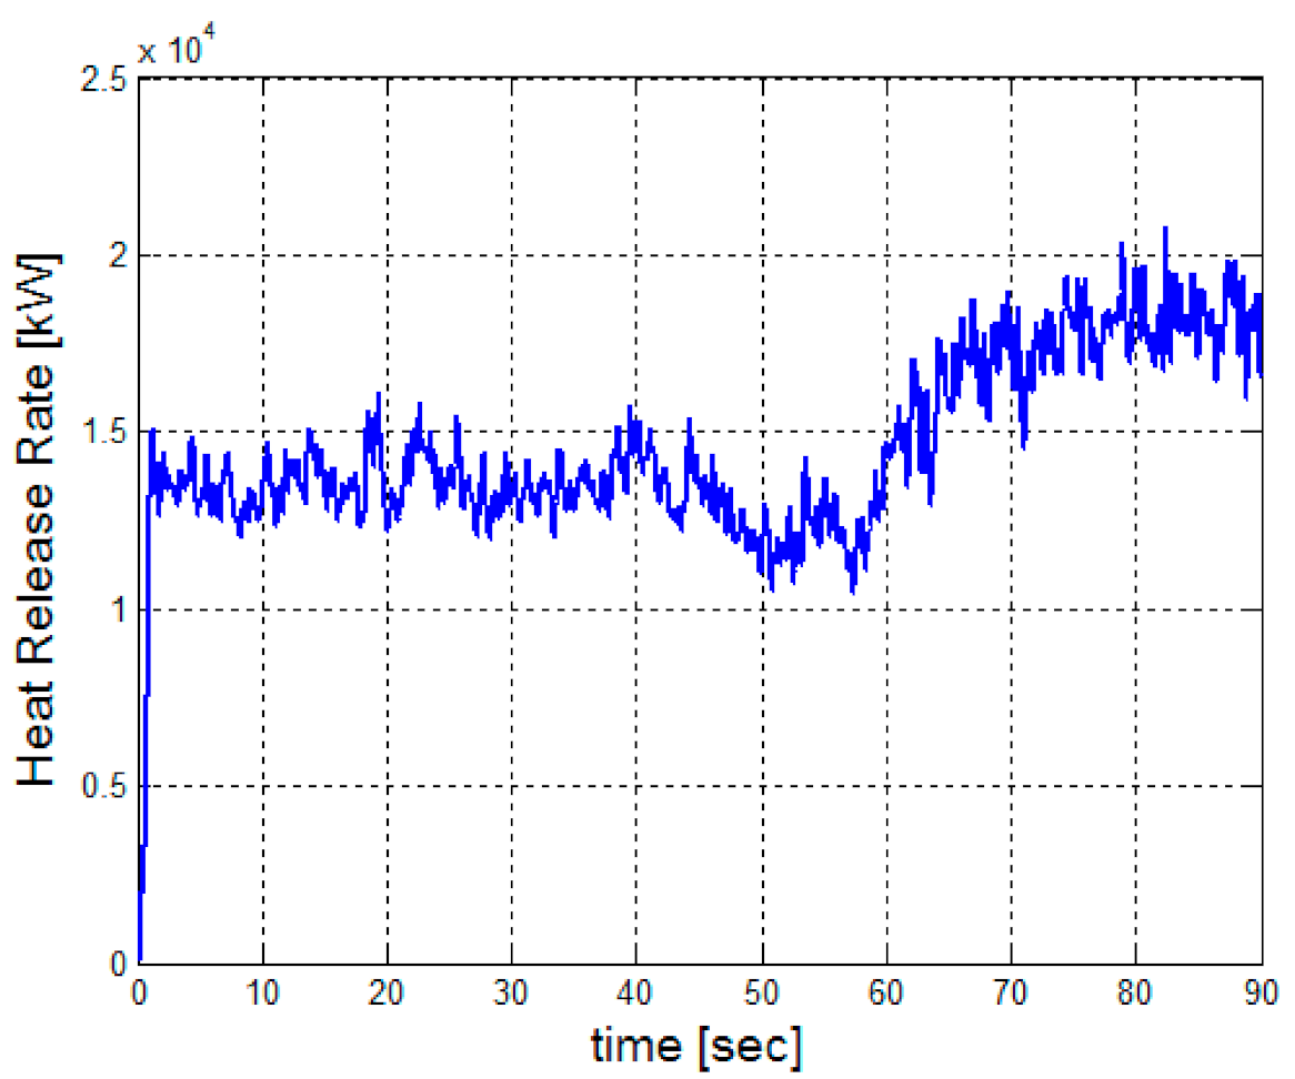
Figure 14. Heat release rate (HRR) of the pet-coke